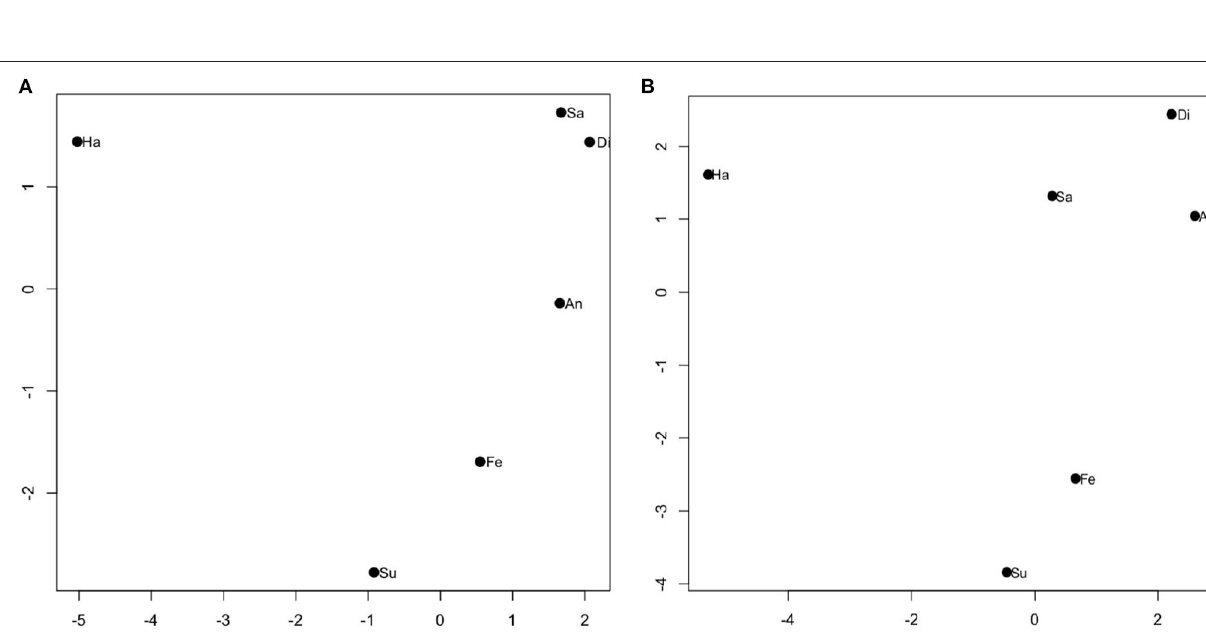
Frontiers in Psychology |